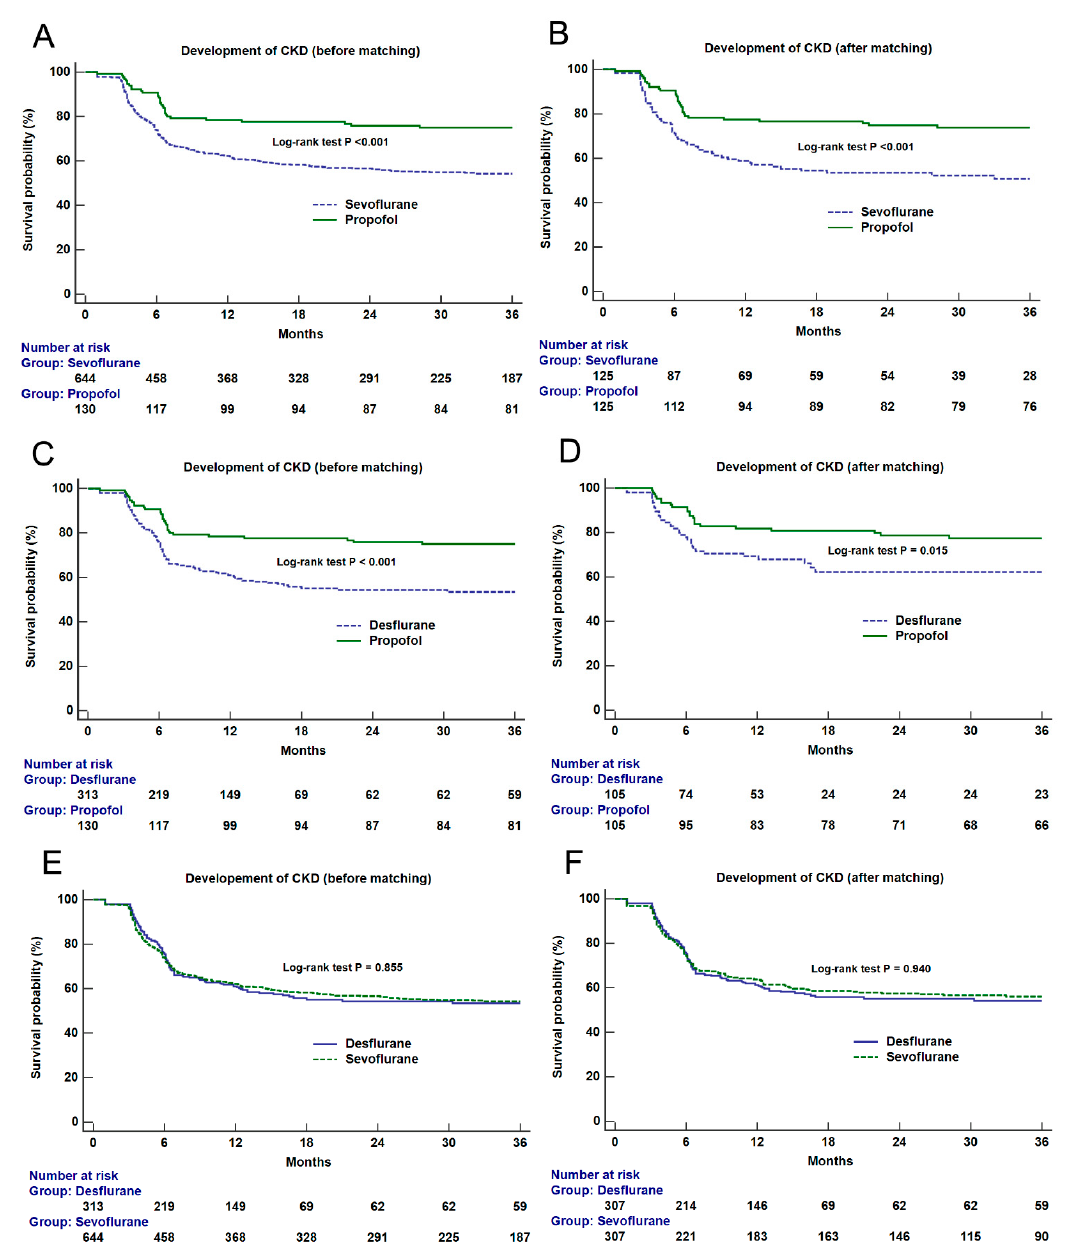
Figure 2. Kaplan-Meier survival curve analyses of new-onset chronic kidney disease stage 3a or high according to the main anesthetic agent groups (propofol vs. sevoflurane, upper, before ( A ) and after ( B ) matching; propofol vs. desflurane, middle, before ( C ) and after ( D ) matching; sevoflurane vs. desflurane, lower, before ( E ) and after ( F ) matching). The results of the log-rank test between groups are shown on the figure.